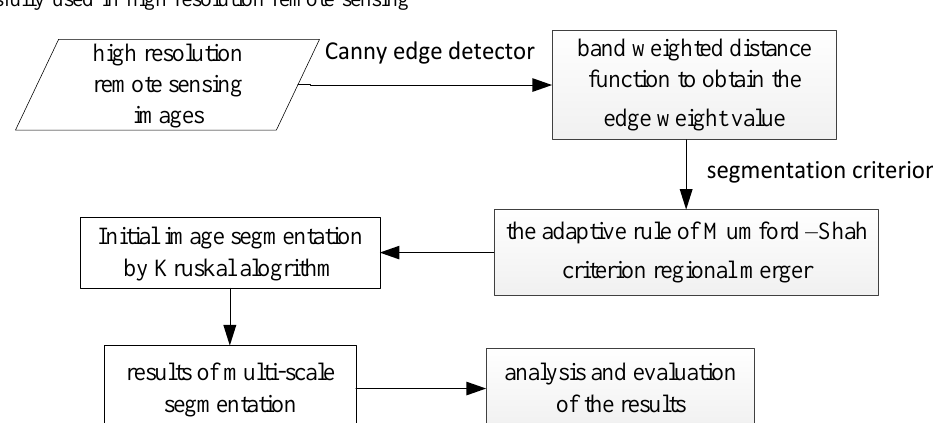
Figure 1. The technical process of multi-scale segmentation by integrating multiple features